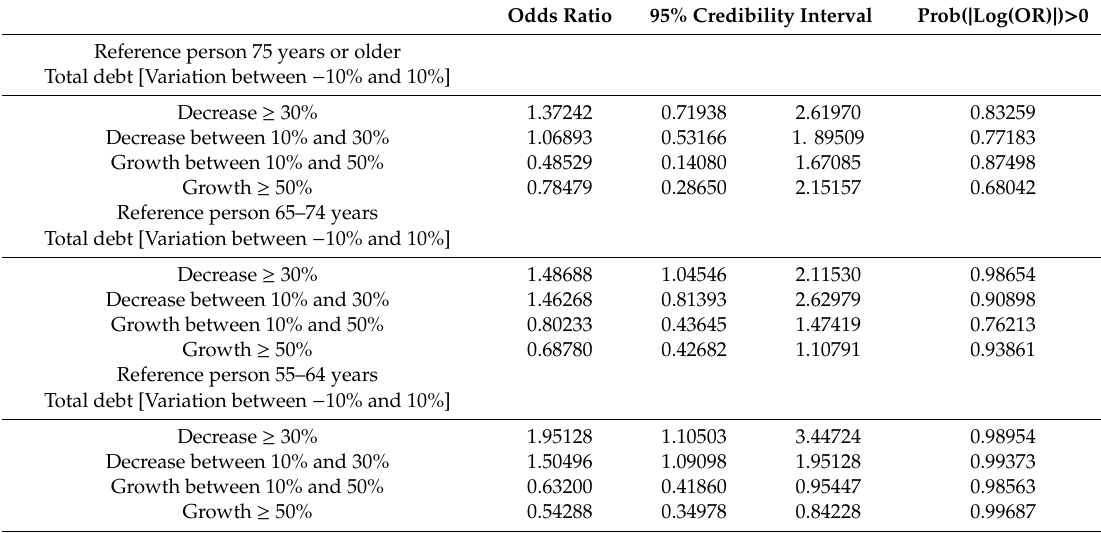
Table 13. Association between the variation in total debt and good and very good self-perceived health.